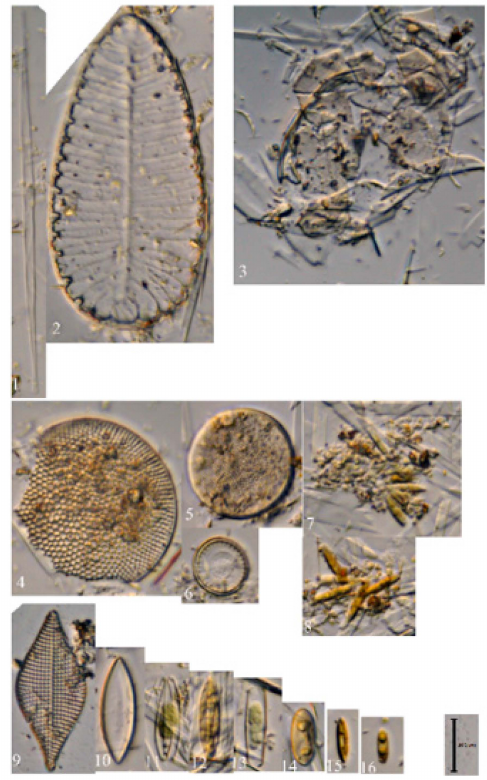
Figure 4. Diatoms subjected to “bead beating” as a part of the DNA extraction protocol. Observations of the remaining lysis buffer sample with beads after total genomic DNA extraction was completed; ( 1 – 6 , 9 , 10 ) Diatoms from the Savannah River, GA, field samples; ( 7 , 8 , 11 – 16 ) Cultures developed at the laboratory: intact cells ( 1 , 2 , 5 , 6 ), with chloroplasts ( 7 , 8 , 11 – 16 ) and broken cells ( 3 , 4 ). ( 1 ) Cylindrotheca gracilis (Brébisson) Grunow; ( 2 ) Surirella splendida (Ehrenberg) Kützing; ( 3 ) Thalassiosira sp.; ( 4 , 5 ) Coscinodiscus sp.; ( 6 ) Puncticulata sp.; ( 7 , 8 , 15 , 16 ) Nitzschia sp.; ( 9 ) Rhaphoneis amphiceros Ehrenberg; ( 10 ) Tryblionella sp.; ( 11 – 14 ) Naviculoid pennate diatoms; Scale bar 20 µ